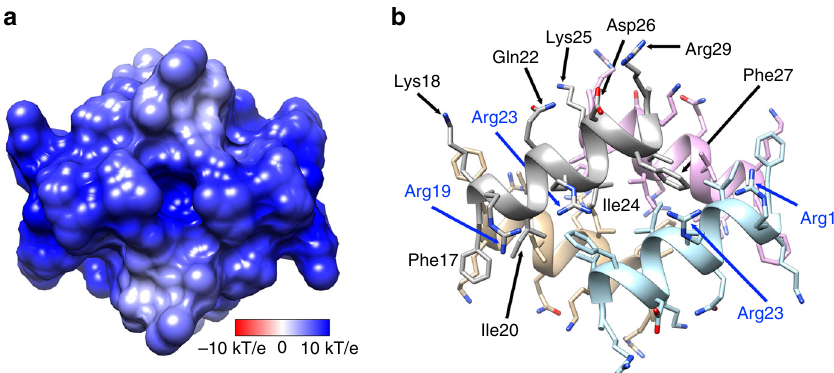
Fig. 4 Positively charged electrostatic surface of the four-helix bundle of hLL-37 17-29 . a A projection of the electrostatic potential ( φ ) onto the molecular surface of the four-helix bundle of hLL-37 17-29 ; the scale bar indicates φ ranges between − 10 kT/e (dark red) and 10 kT/e (dark blue). b The bundle is displayed as ribbons, in the same orientation as in panel a, with side chains shown as sticks. The ribbons and carbons of each of the four helices are colored differently (gray, light blue, tan and pink) and non-carbon atoms are colored by atom type (oxygen in red and nitrogen in blue). Residues are labeled. Arg19 and Arg23 (labeled blue) from two helices lie across each side of the bundle.